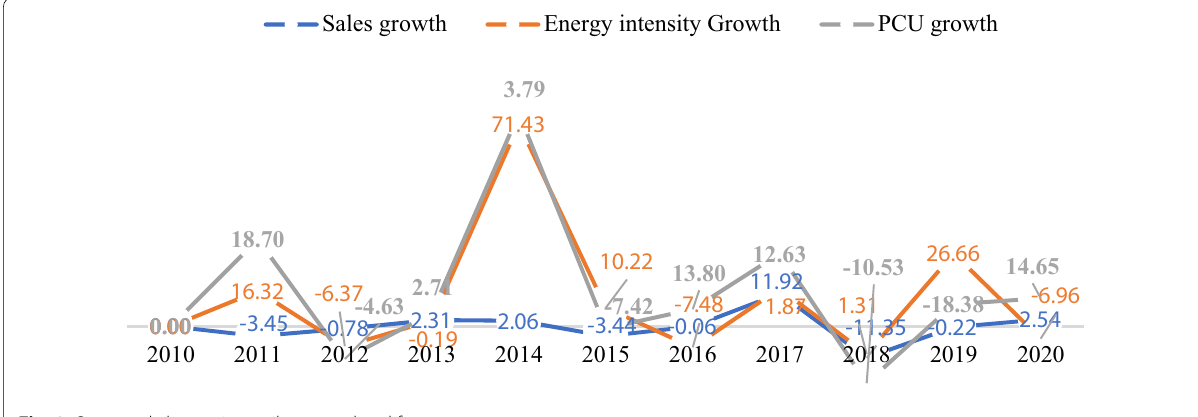
Fig. 8 Structural change in textile, apparel and footwear